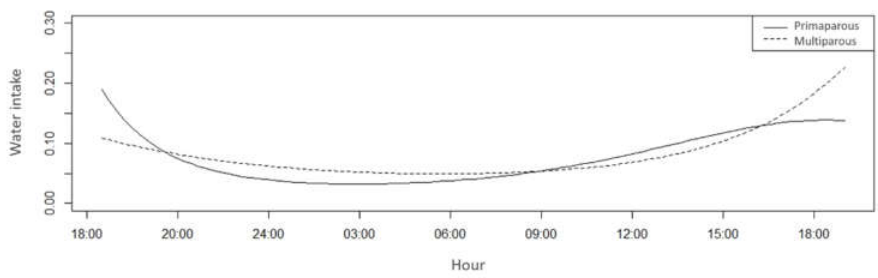
Figure 9. Water intake probability of primiparous (solid line) and multiparous cows (dotted line) in a compost barn.